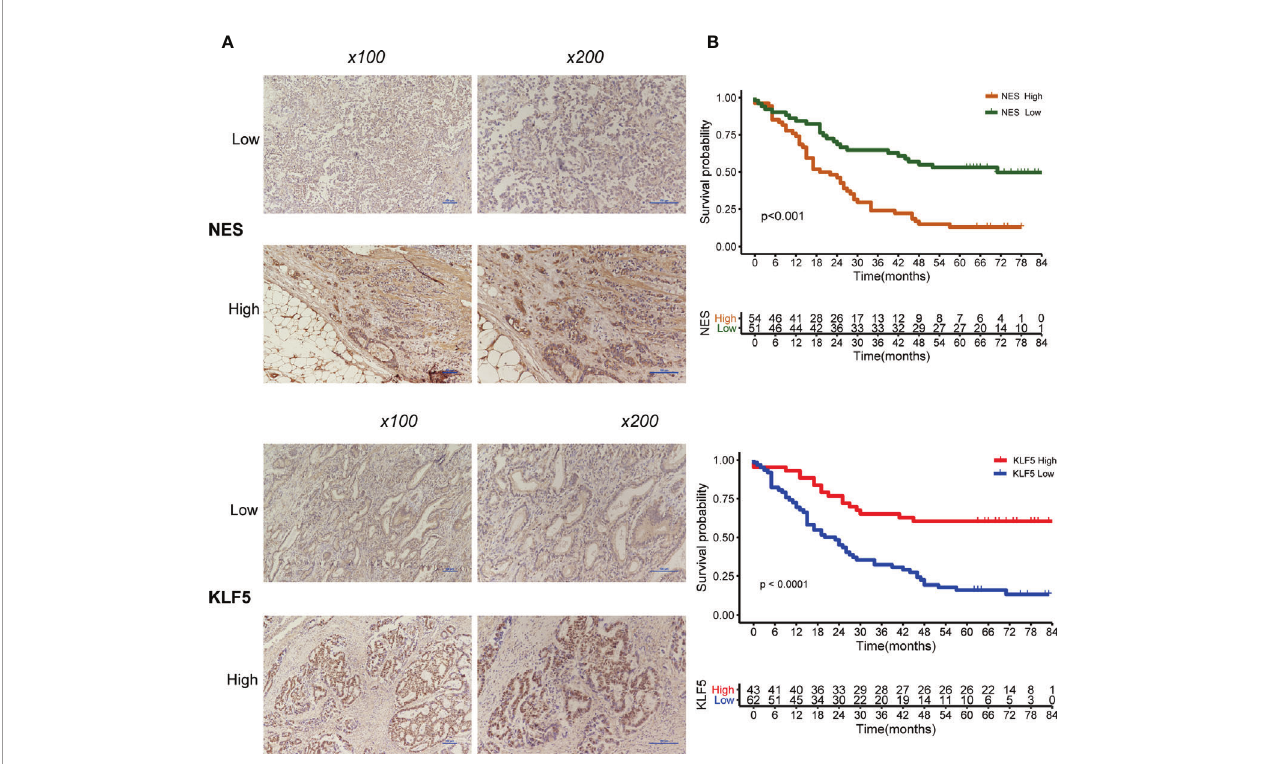
FIGURE 9 | Expression of NES and KLF5 in gastric cancer (GC) tissue and Kaplan-Meier analysis. (A) Low and high expression of NES and KLF5 in GC specimens; (B) Kaplan ‐ Meier survival curves based on NES and KLF5.